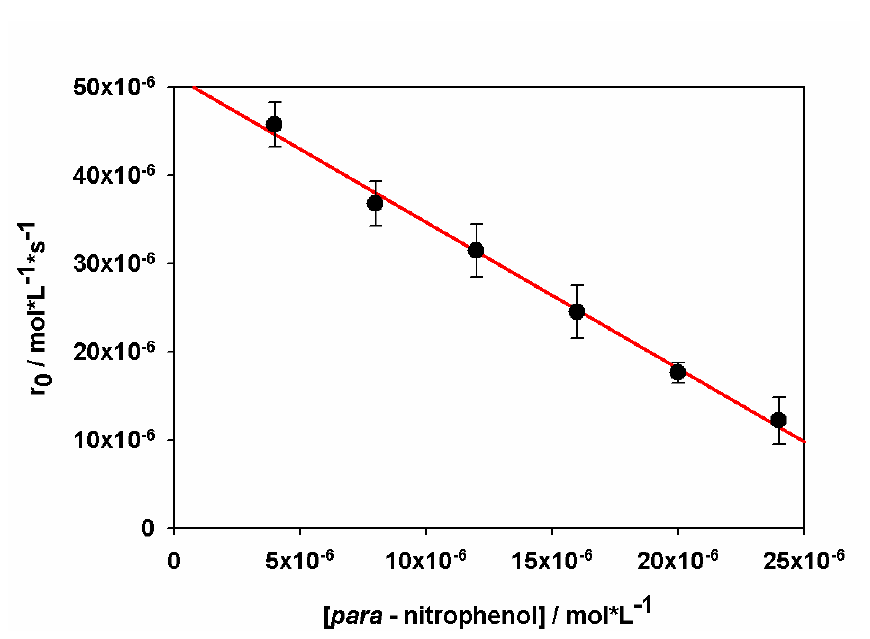
Fig. 4 Calibration graph for the determination of para -nitrophenol. [H 2 O 2 ] = 1.74 · 10 − 2 mol/L, pH = 7; t = 20 ◦